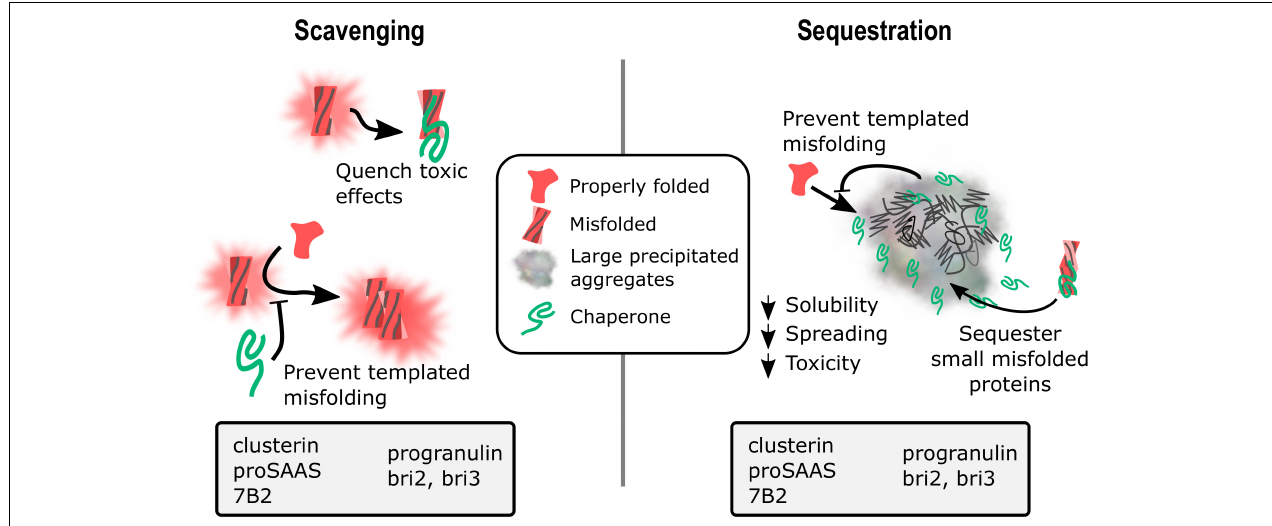
FIGURE 1 | Potential mechanisms for extracellular chaperone action in neurodegenerative disease: Scavenging and sequestration. A schematic diagram showing two proposed mechanisms of action for extracellular chaperone activity on misfolded and aggregating substrates. (1) Scavenging. Chaperones can bind soluble monomers and low molecular weight oligomers to prevent toxic effects from the misfolded protein as well as block the template misfolding/aggregation of natively folded monomers. Chaperones with data showing the ability to block aggregation of misfolded proteins are listed in the gray box. (2) Sequestration. Chaperones can interact with soluble misfolded proteins and drive their recruitment into insoluble aggregates, reducing toxic species solubility, spreading ability, and toxicity. Chaperones can also serve as a buffer to block templated misfolding of natively folded proteins, and may also interact with insoluble aggregates. Chaperones with data showing colocalization with amyloid plaques, neurofibrillary tangles, Lewy bodies, and/or intracellular inclusions are listed in the gray